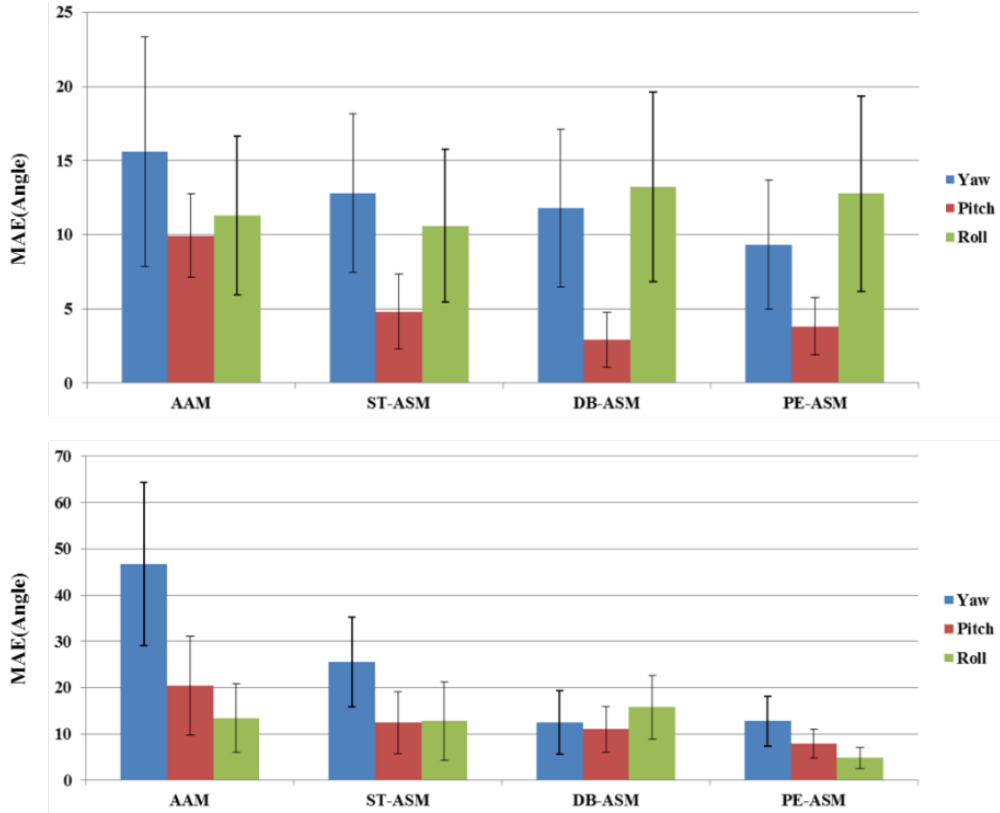
Figure 10. Performance comparison between four face models using BU DB (Boston University database) ( top ) and our custom-made database ( bottom ). Three different head rotations are indicated with blue, red, and green, respectively.